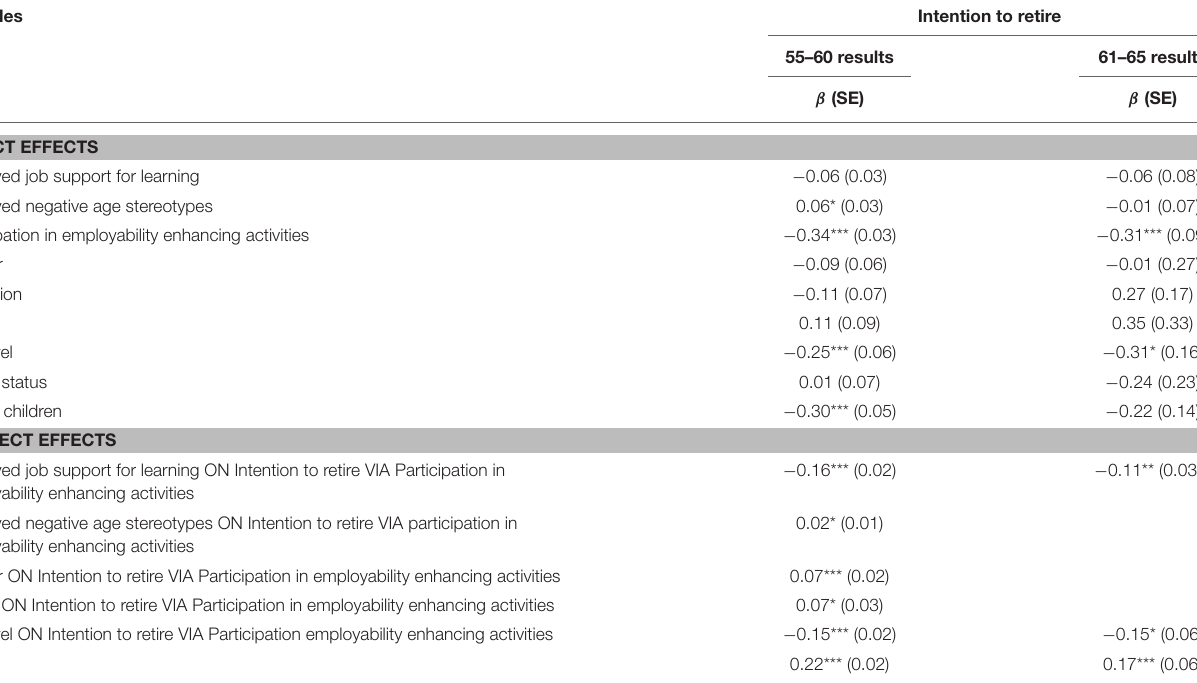
TABLE 5 | Structural path